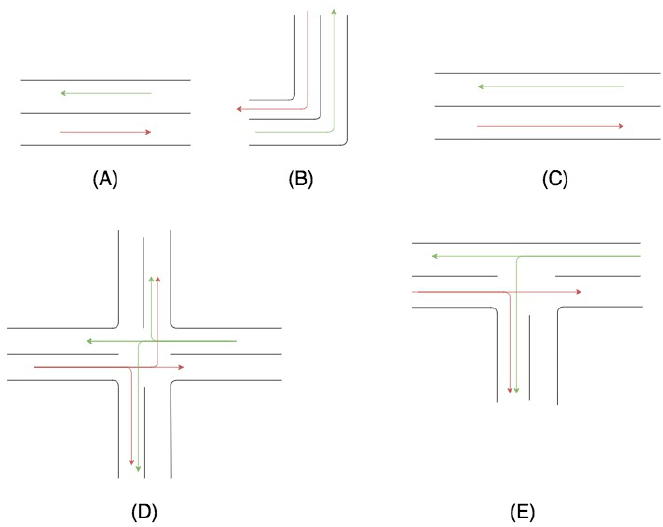
Figure 2. Urban Street Network roads and intersections, ( A ): two-way local road, ( B ): two-way corner road, ( C ): two-way fixed road, ( D ): eight-way intersection and ( E ): two-way